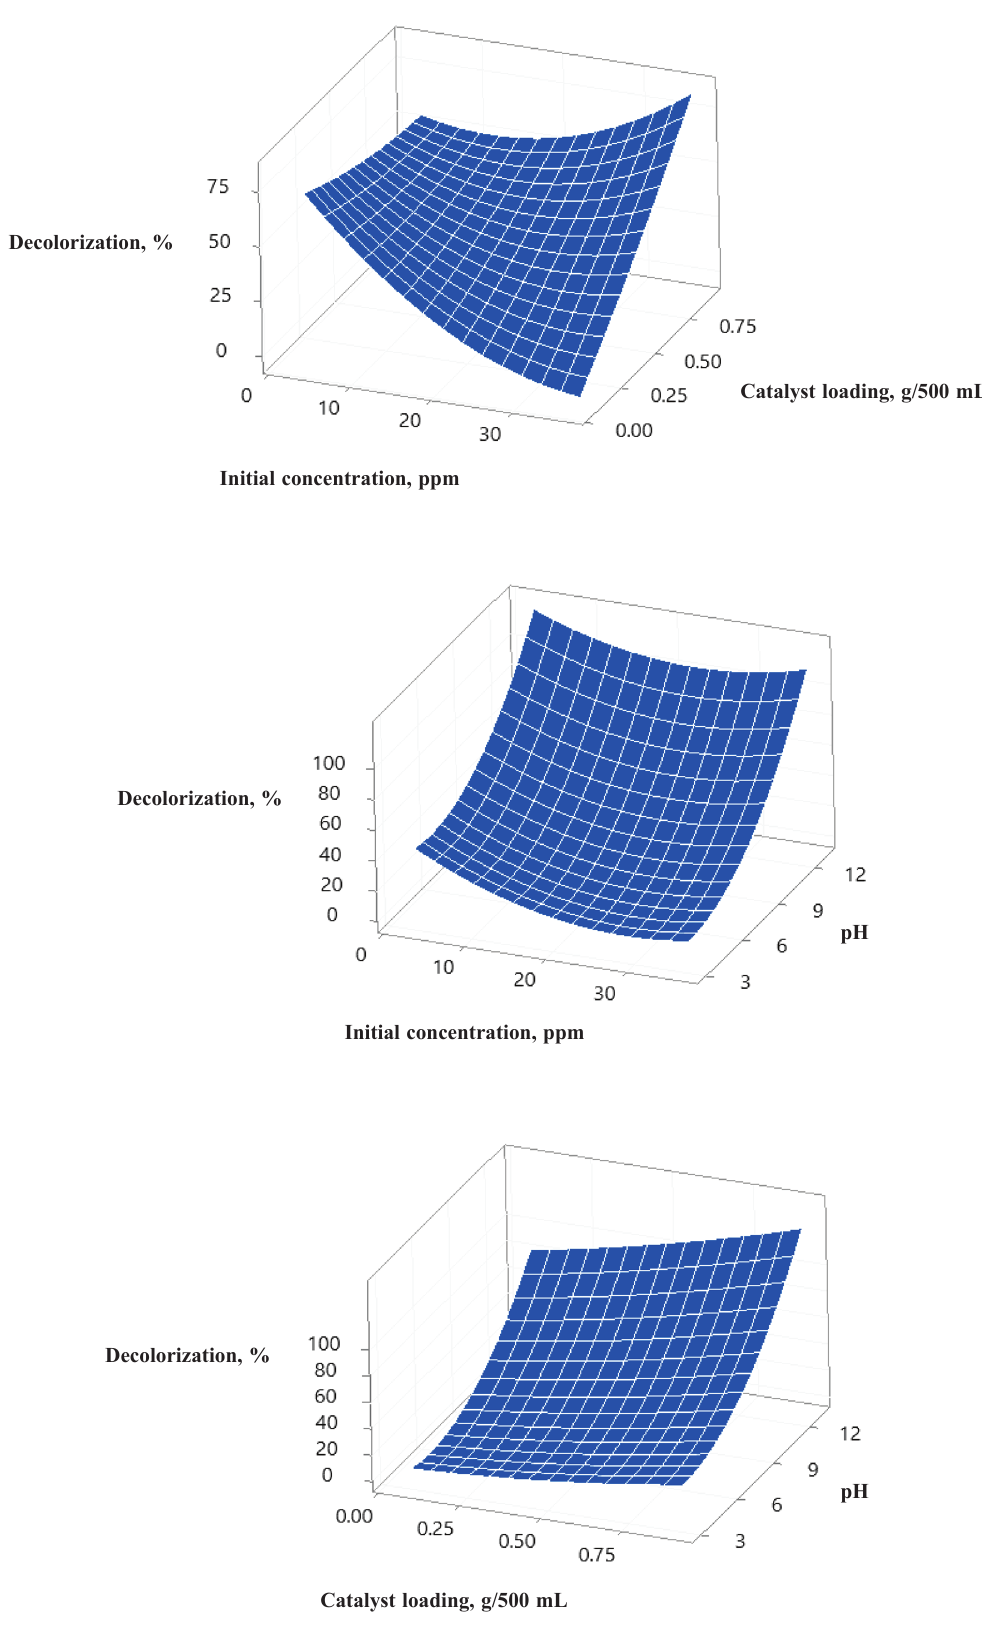
Fig. 6 – Surface plots of: decolorization % vs catalyst loading, initial concentration (a), decolorization % vs pH, initial concentra- tion (b), and decolorization % vs pH, catalyst loading